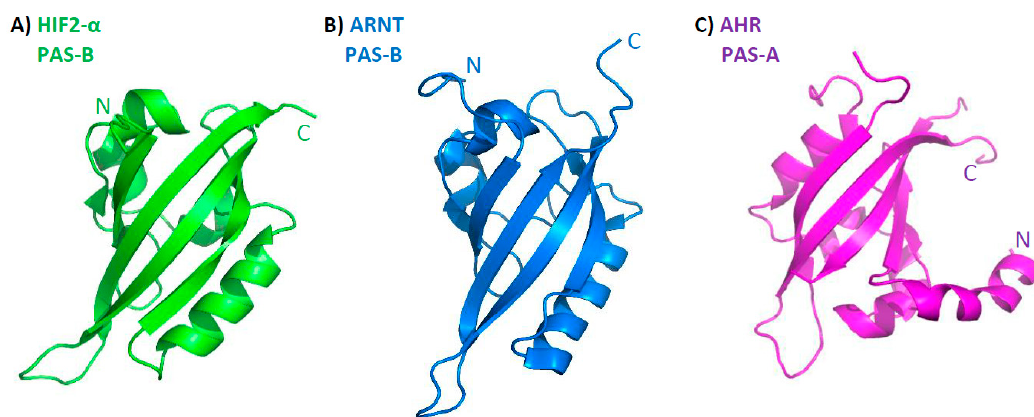
Figure 2. Representation of the PAS fold: a five-stranded antiparallel β -sheet is flanked by several α -helices. ( A ) HIF2- α PAS-B obtained with NMR (PDB 1P97), ( B ) ARNT PAS-B obtained with NMR (PDB 1X0O), ( C ) AHR PAS-A domain obtained with X-ray (PDB 4M4X).